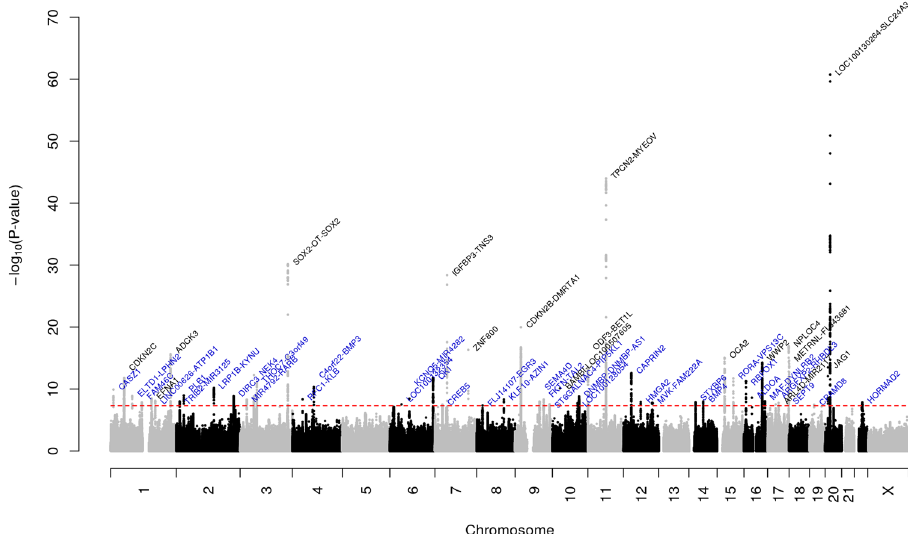
Fig. 1 Manhattan plot of the multiethnic combined (GERA + UKB) GWAS meta-analysis of cataract. The y-axis represents the -log 10 ( P -value); all P -values derived from logistic regression model are two-sided. The red dotted line represents the threshold of P = 5 × 10 − 8 which is the commonly accepted threshold of adjustments for multiple comparisons in GWAS. Locus names in blue are for the novel loci and the ones in dark are for the previously reported ones.